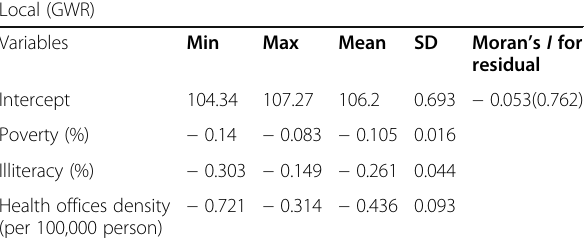
Table 4 Summary of GWR model